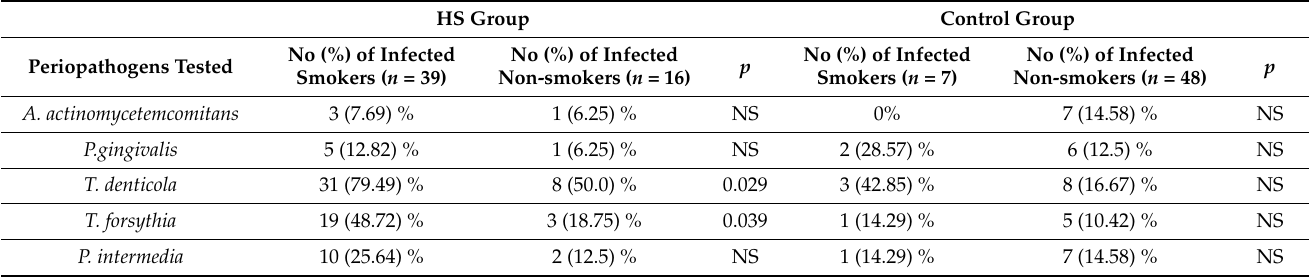
Table 4. Comparison of the prevalence of periodontal pathogens among smokers and non-smokers. HS Group Control